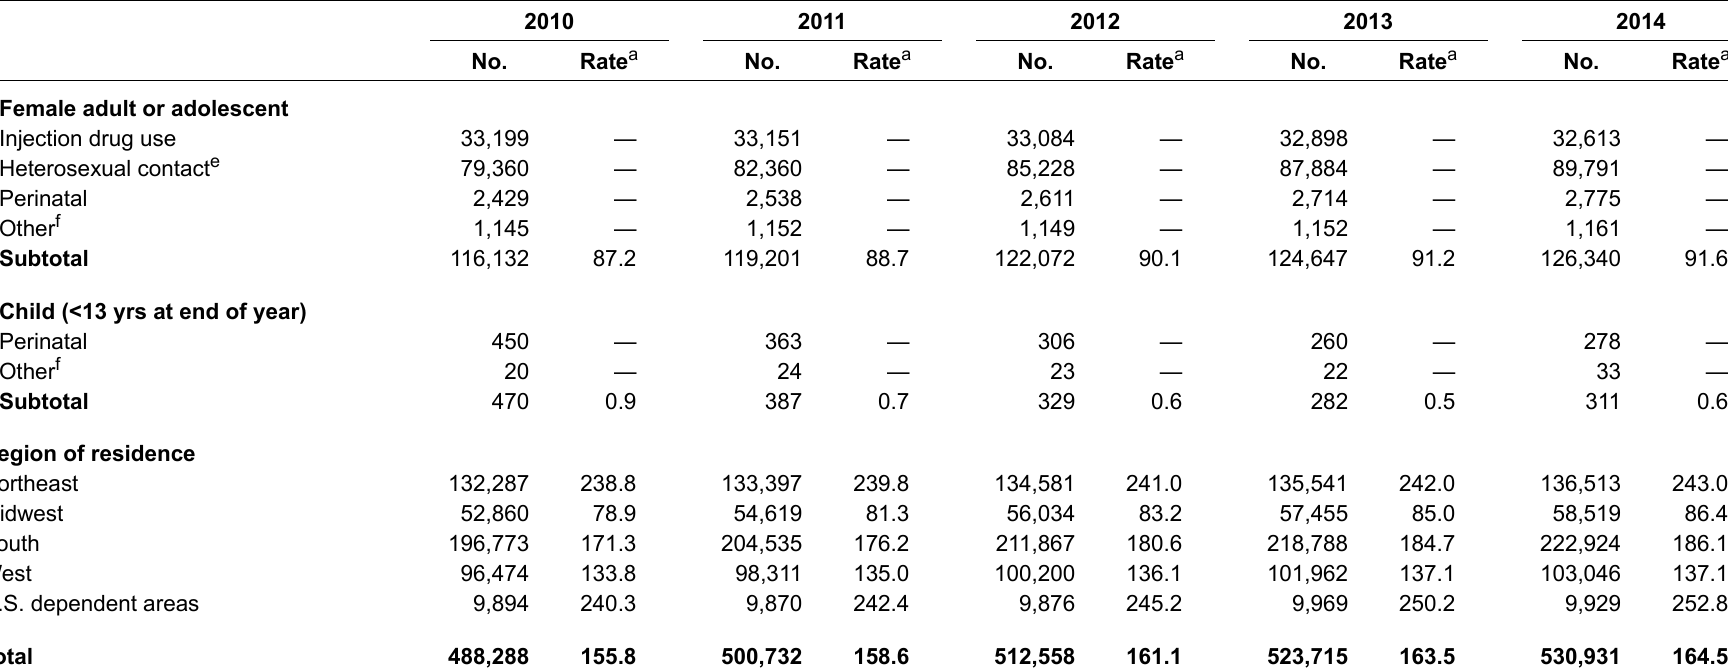
Table 19b. Persons living with diagnosed HIV infection ever classified as stage 3 (AIDS), by year and selected characteristics, 2010–2014—United States